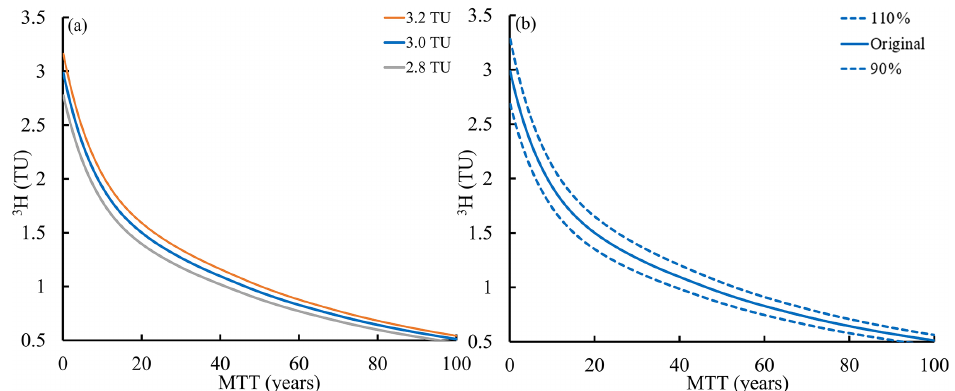
Figure 8. (a) Impacts of varying the 3 H activity of modern rainfall from 2.8 to 3.2TU on MTTs calculated using the exponential piston flow model (EPM ratio = 0.33). (b) Impacts of varying 3 H activity of rainfall between 90% and 110% of its assumed values on mean transit time calculated using the exponential piston flow model (EPM ratio = 0.33).